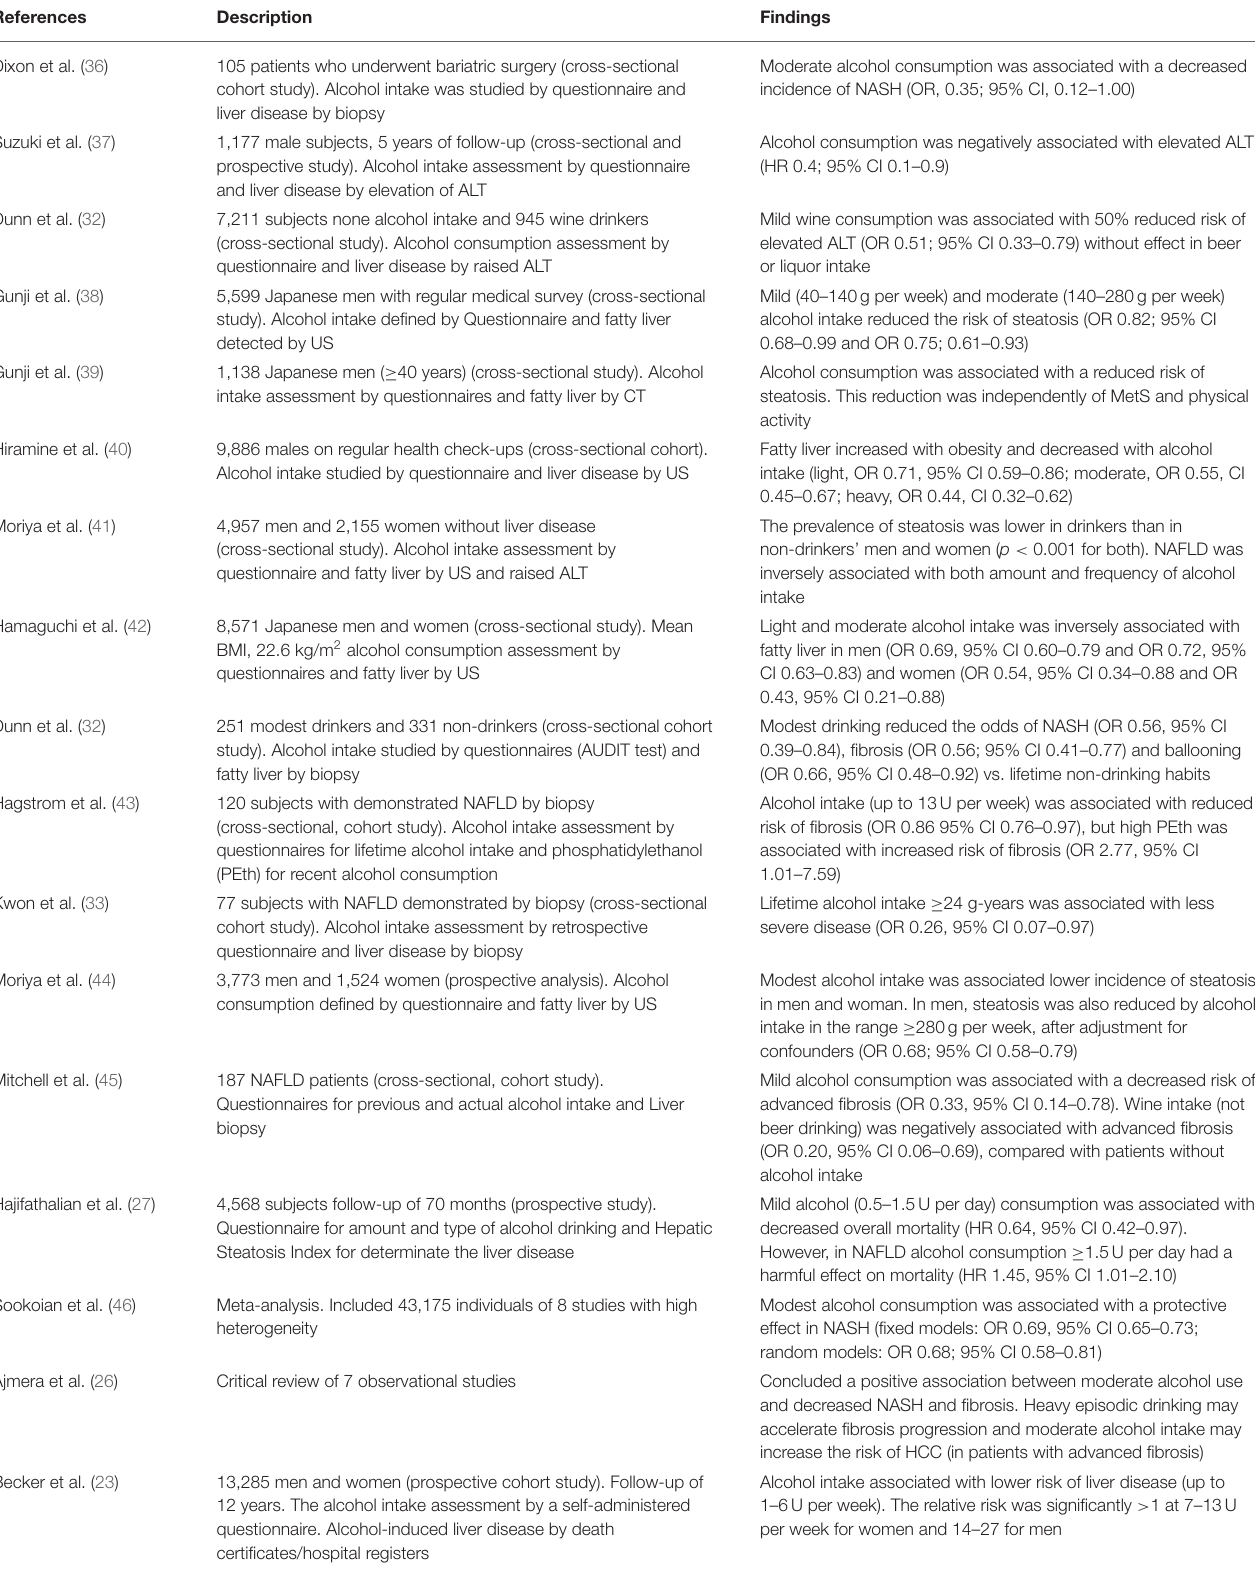
TABLE 1 | Studies assessing the effect of moderate alcohol intake on